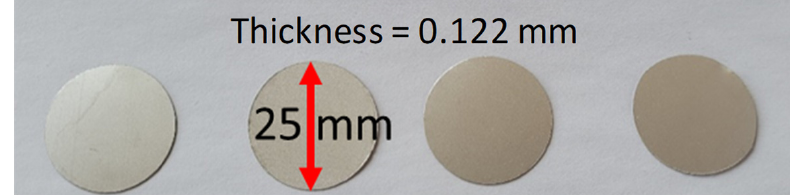
Figure 1. PVDF transducers cut into a disk